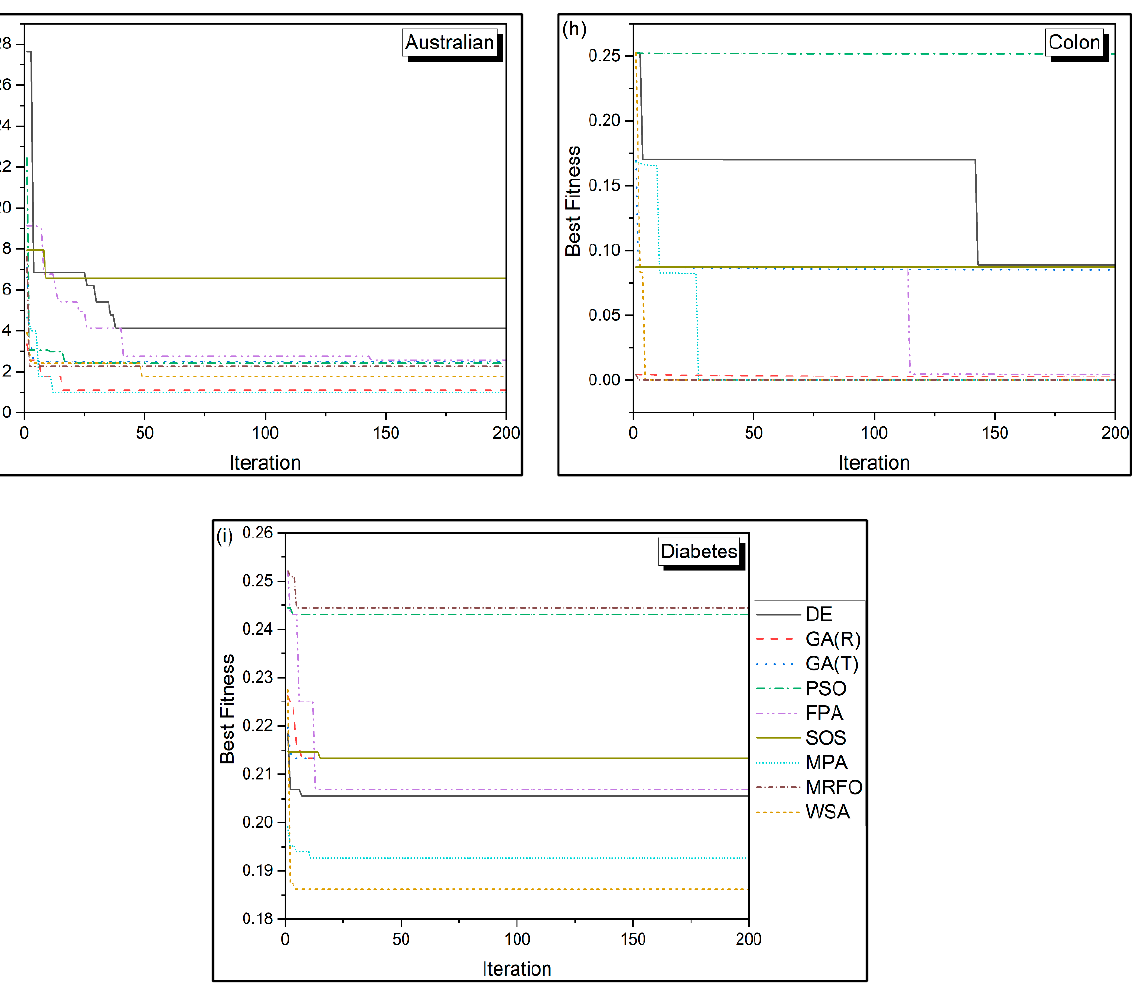
Figure 2. Convergence of each algorithm for different datasets ( a ) Heart ( b ) Ionosphere ( c ) German ( d ) Breast ( e ) Sonar ( f ) Ovarian cancer ( g ) Australian ( h ) Colon ( i ) Diabetes. Table 5. Best classification accuracy achieved by each algorithm for each